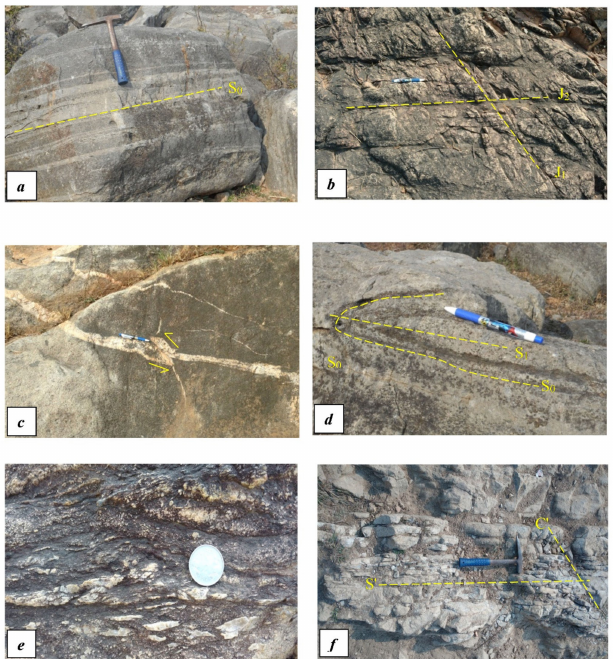
Figure 9. Field photographs showing: ( a ) primary layering (S0) in layered anorthosite near Sapneri village; ( b ) prominent two sets of joint pattern in hornblende granite at the south of Misir Bigah; ( c ) displacement of pegmatite vein within homophanous biotite granite also showing the sinistral sense of movement at NE of Naugarh village; ( d ) early tight isoclinal fold (F1) in layered gabbroic anorthosite at the east of Adampur village; ( e ) highly sheared quartz vein in hornblende granite at SE of Daulatpur village; and ( f ) development of S’-C’ fabric in homophanous biotite granite at South of Dhakra